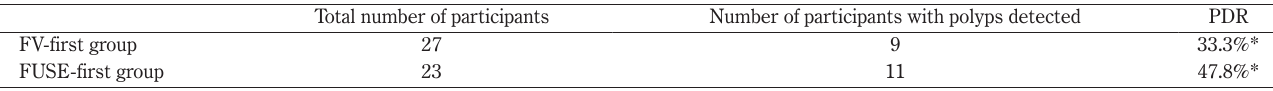
Table 4 Polyp detection rate in the first observation